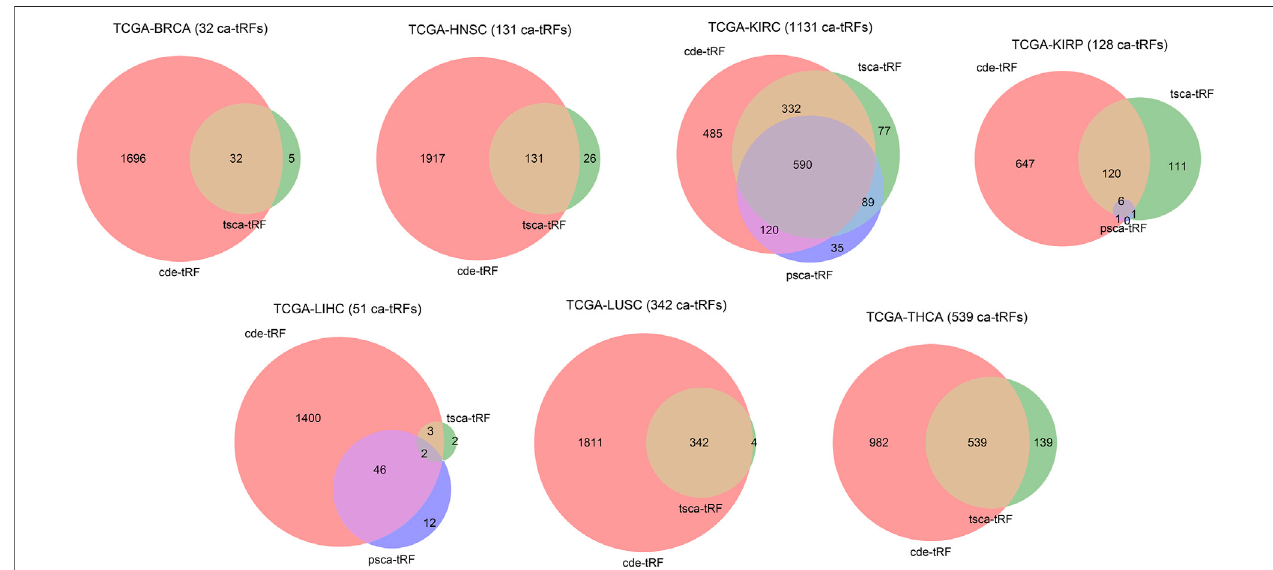
FIGURE 2 | Venn diagram illustrating the intersections of three candidate ca-tRF sources. Three candidate ca-tRF sources, including the differentially expressed tRFs between cancer samples and normal samples (cde-tRF), the tRFs signi fi cantly correlated with clinical tumor stage (tsca-tRF) and the tRFs signi fi cantly correlated with patient survival (psca-tRF) were considered. For each cancer, the tRF numbers of these three sets and their intersections are shown by Venn diagram. If one tRF belongstoatleasttwosets(i.e.,appearsinanyintersectionarea),thenitwaslistedasaca-tRFofthecorrespondingcancer.The fi nallydeterminednumbersofca- tRFs are shown following the cancer